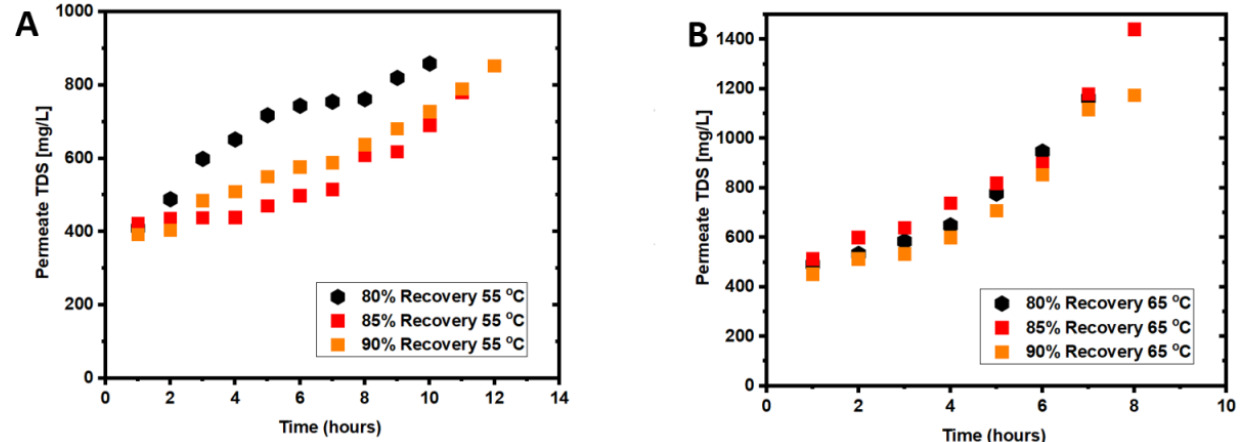
Figure 3. Permeate TDS for seawater treatment: ( A ) permeate TDS concentration for seawater treatment at 55 ◦ C at 80%, 85%, and 90% recoveries; ( B ) permeate TDS concentration for seawater treatment at 65 ◦ C at 80%, 85%, and 90% recoveries.